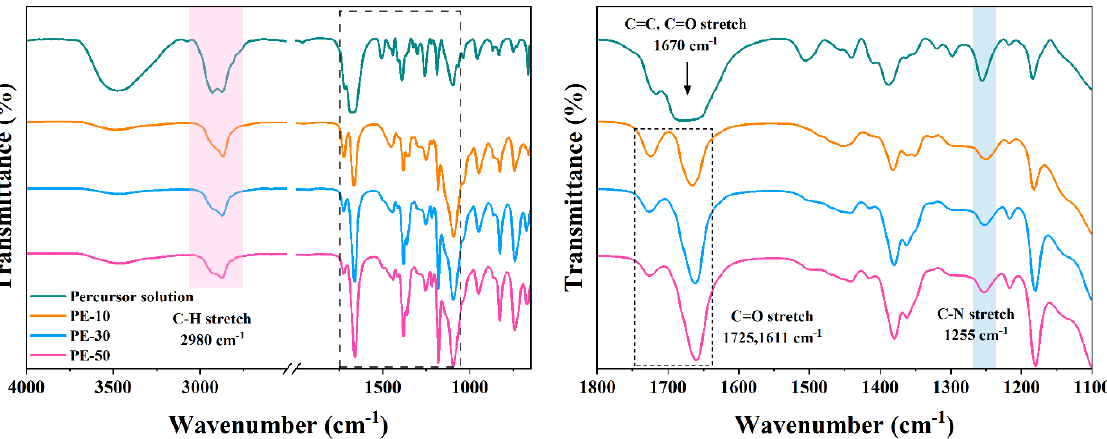
Figure 2. FT − IR spectra of PEs’ precursor solution and after UV − curing polymerization and enlarged Figure 2. FT-IR spectra of PEs’ precursor solution and after UV-curing polymerization and enlarged graph (from 1800 to 1100 cm − 1 wavenumber). graph (from 1800 to 1100 cm − 1